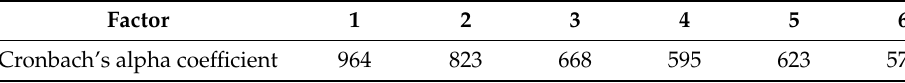
Table 7. Cronbach’s alpha coefficient for individual factors.